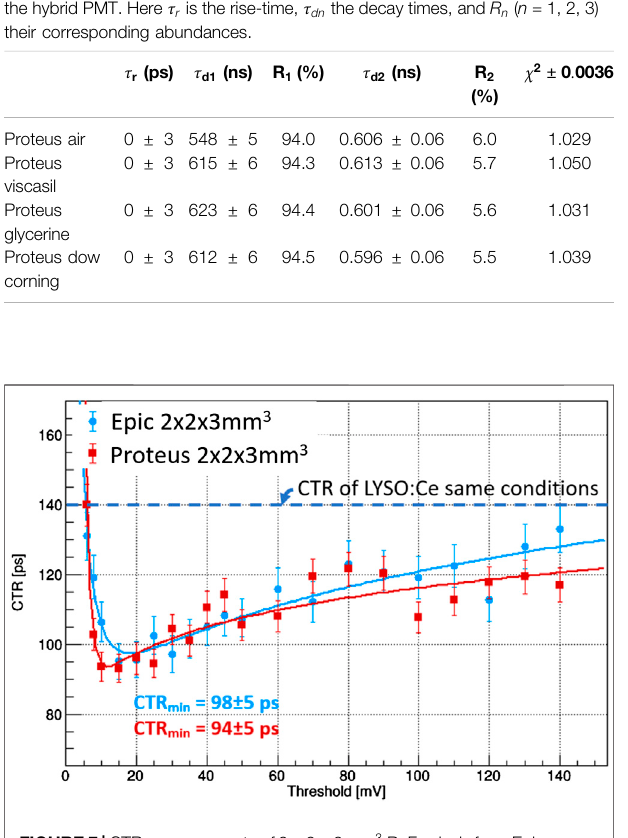
Frontiers in Physics |